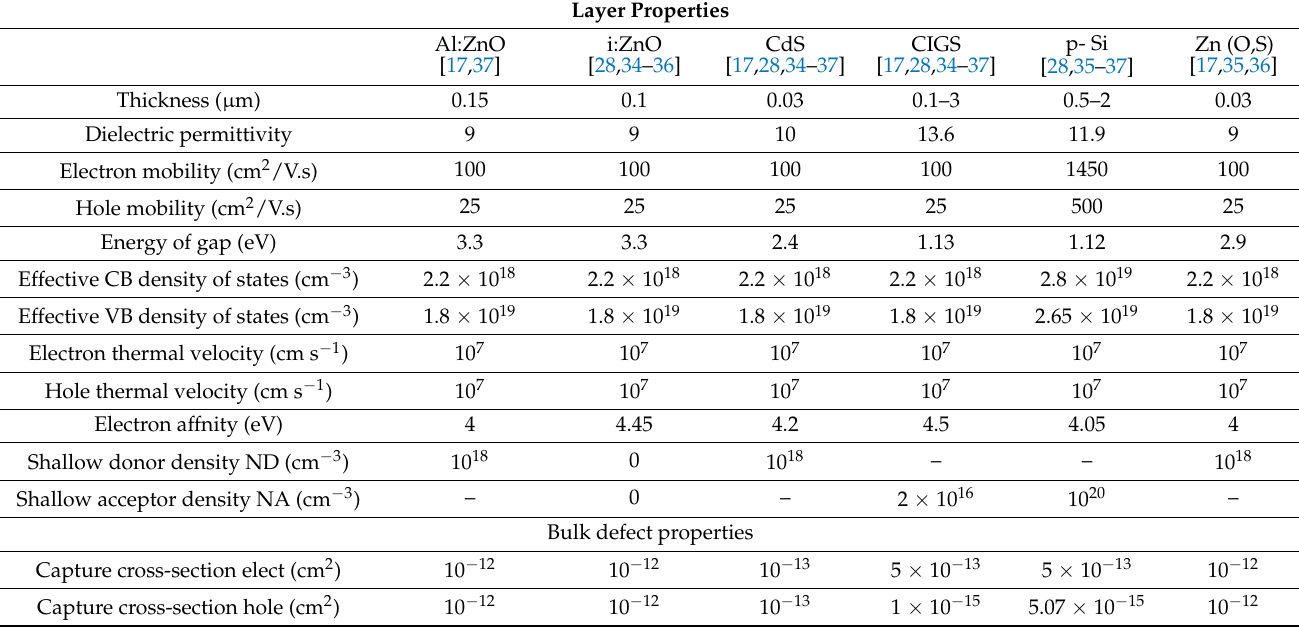
Table 1. Baseline parameters for modeling CIGS solar